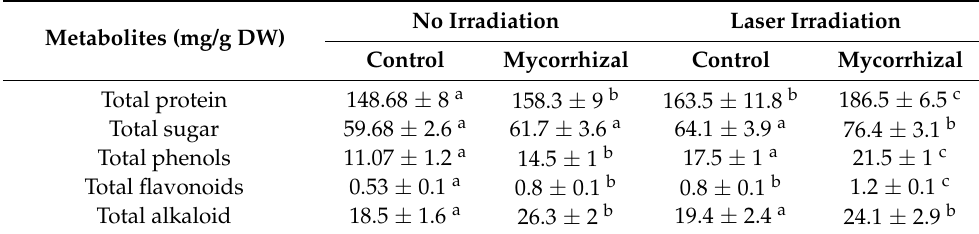
Figure 1. Impact of laser light and mycorrhizal co-treatment on plant biomass. Values are presented as mean ± SD whereas, * = p < 0.05, ** = p < 0.01. Table 2. Biological content of P. graveolens . Table 2. Biological content of P. graveolens .